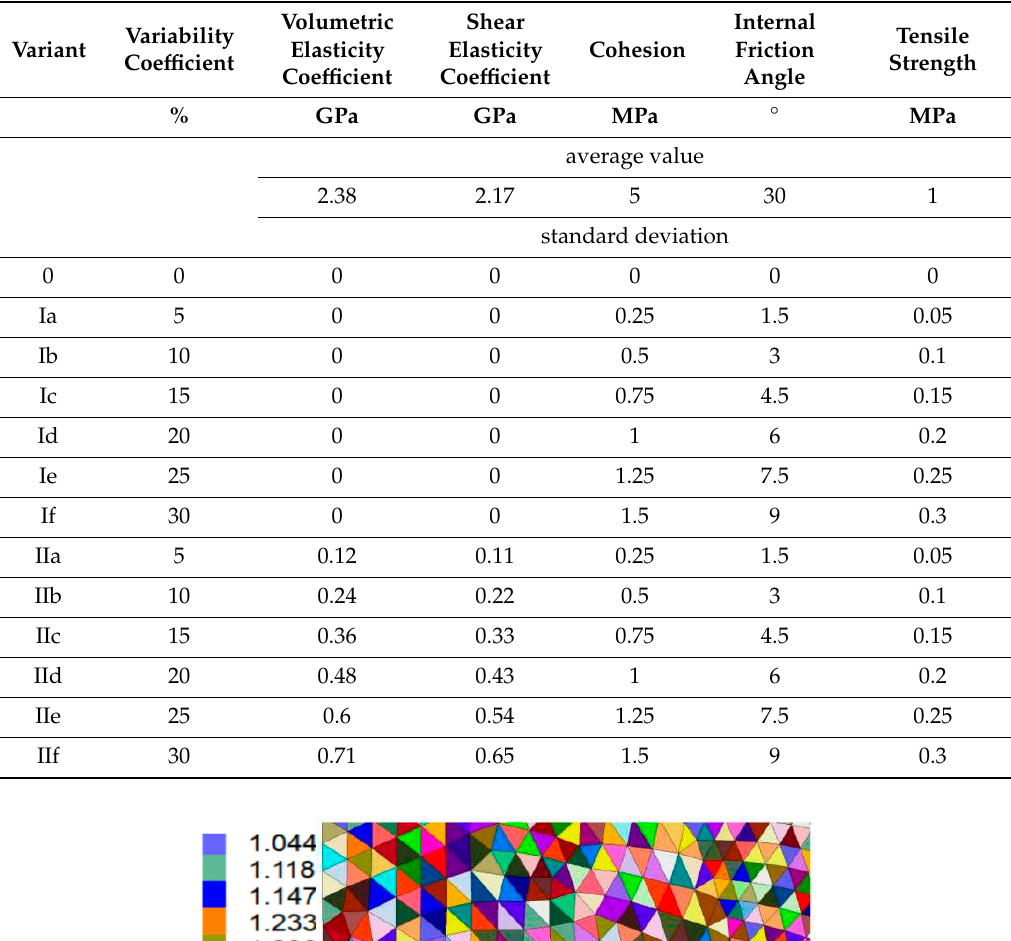
Table 1. List of the adopted material properties for variants, taking into account the variability of strength parameters.